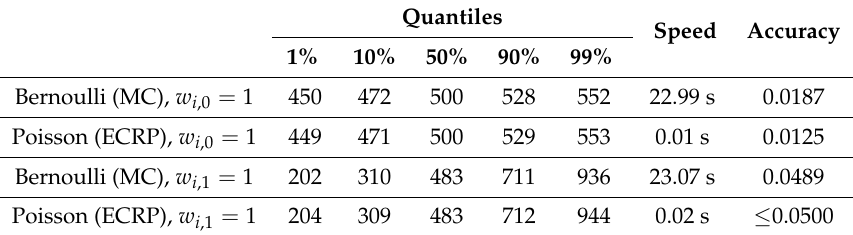
Table 5. Quantiles, execution times (speed) and total variation distance (accuracy) of Monte Carlo with Bernoulli deaths and 50,000 simulations, as well as the extended CreditRisk + (ECRP) model with Poisson deaths, given a simple